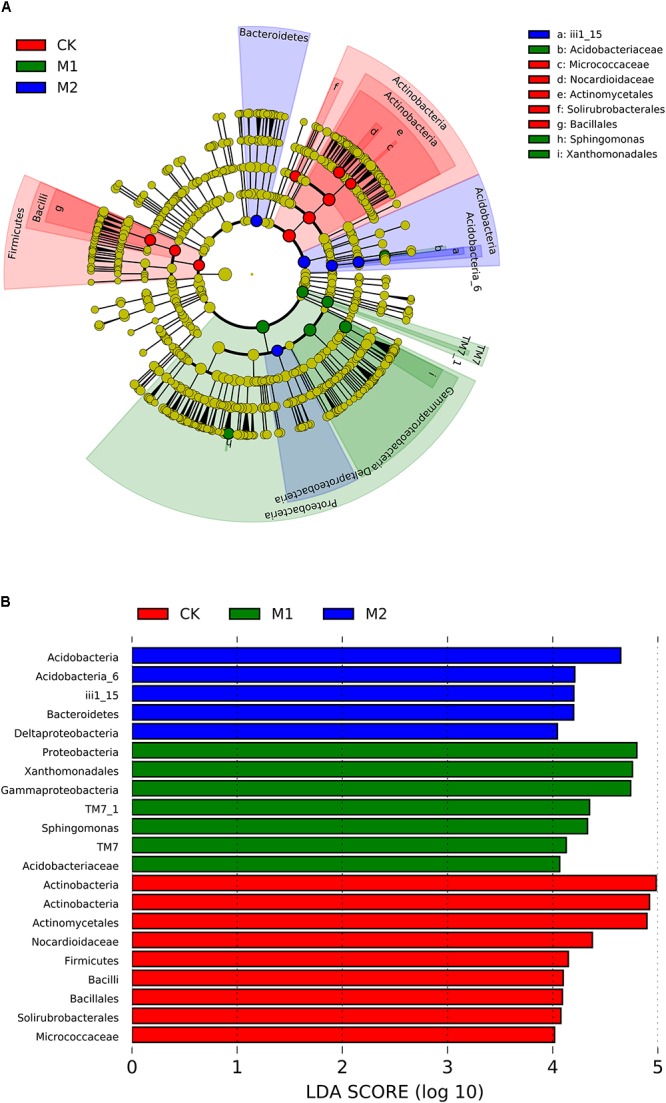
Cladogram (A) and LDA score (B) of LEfSe analysis of bacterial community among CK (Red), M1 (green) and M2 (blue) treatments. Only the taxa with meeting a significant LDA threshold value of >4 were shown. M1, microbial co-inoculants 1; M2, microbial co-inoculants 2; CK, non-inoculated.